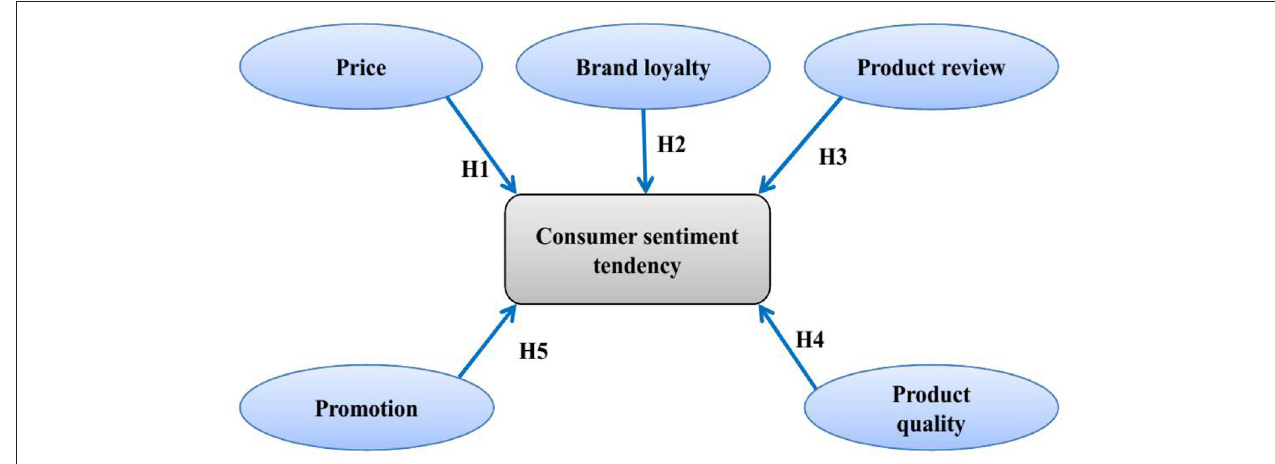
FIGURE 1 | Conceptual framework.